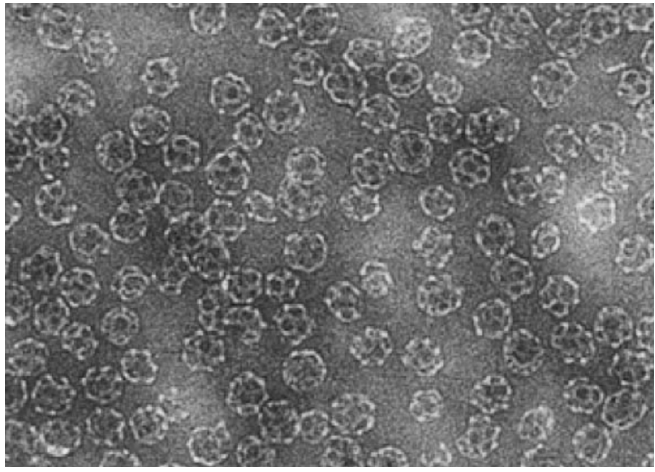
Figure 2. Electron micrograph of immune stimulating complexes showing 40 nm particles containing envelope proteins from influenza virus. Cholesterol and Quillaja saponin form hexagonal rings glued together by lipid, e.g., phosphatidylcholine, to form the spherical structure. Reprinted with permission from ref. [85], Copyright © 2004, Elsevier